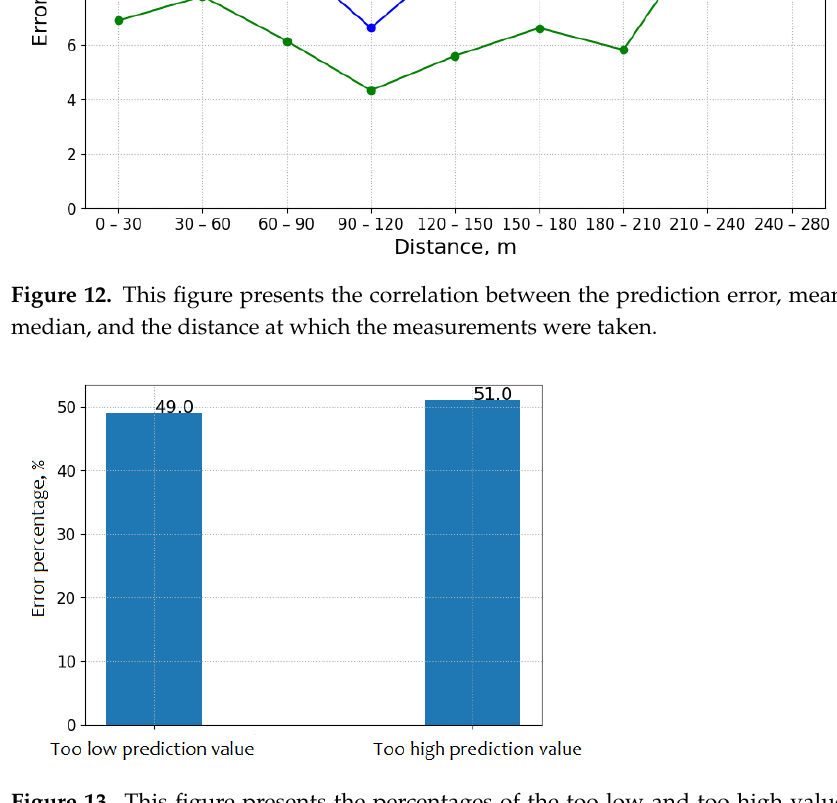
Figure 13. This figure presents the percentages of the too low and too high values predicted by the